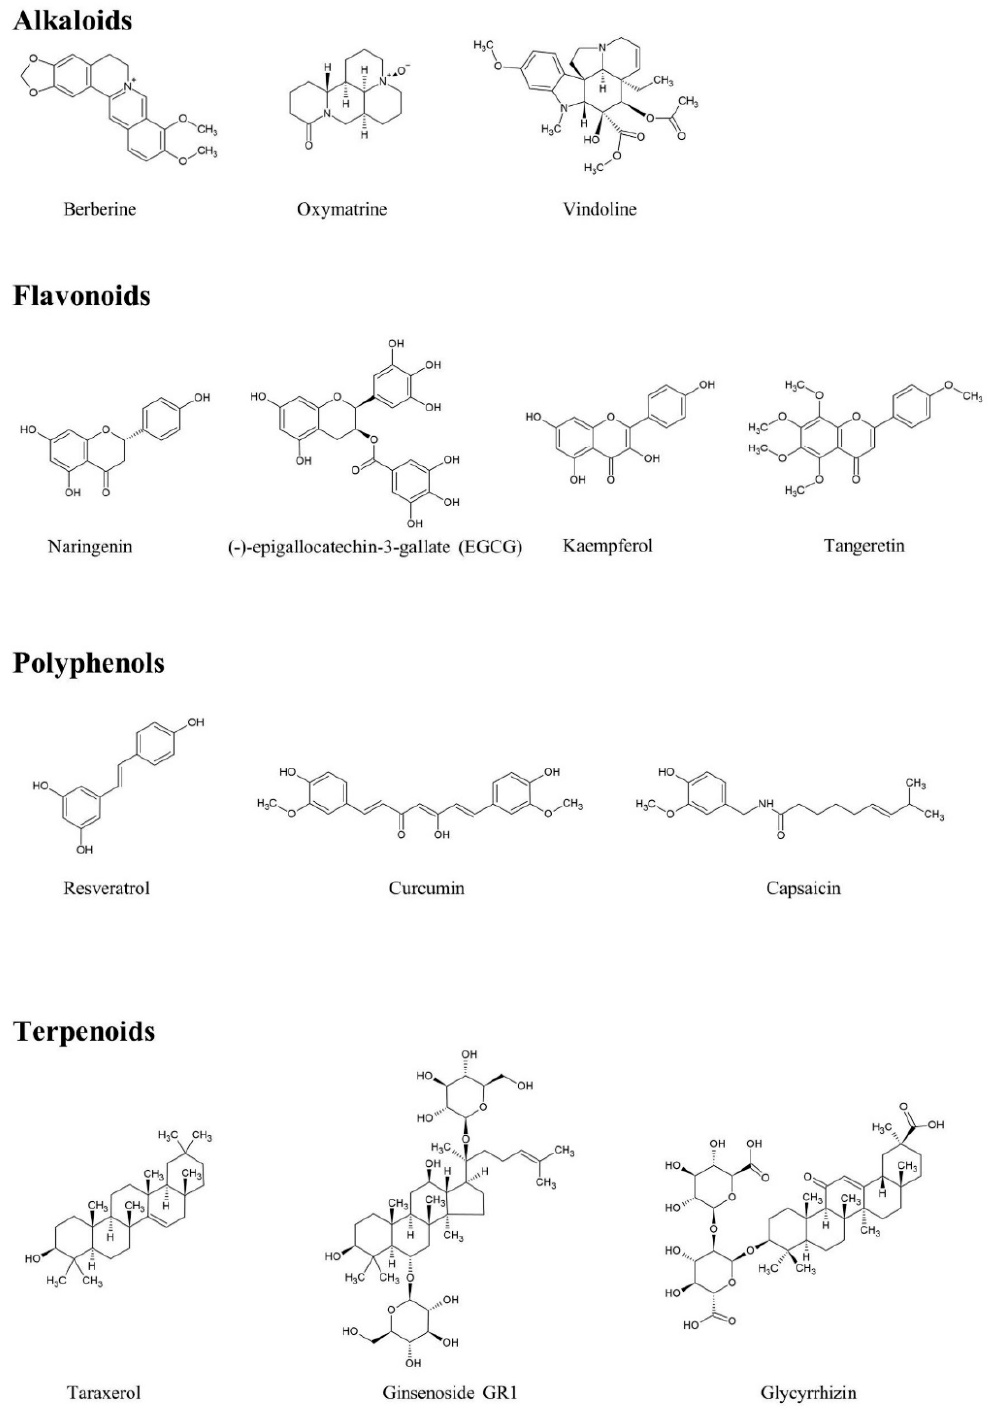
Figure 3. The chemical structures of anti-T2DM compounds introduced in this